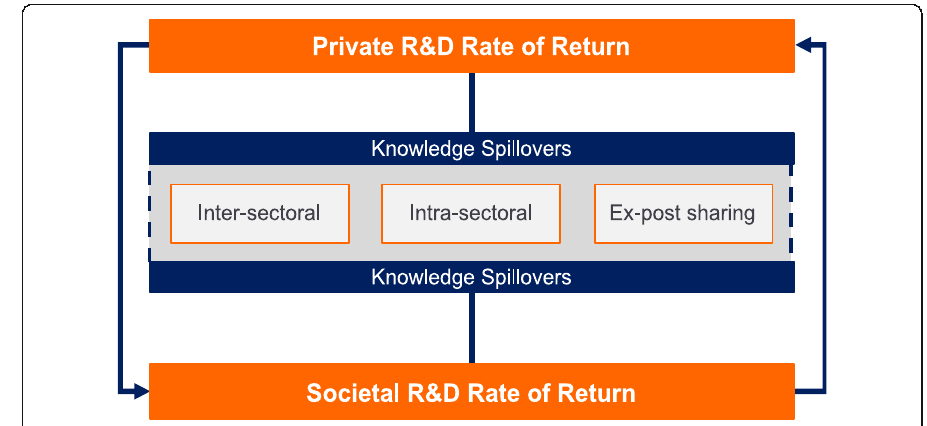
Fig. 1 Knowledge Transfer Channels and R&D Rate of Return (Own